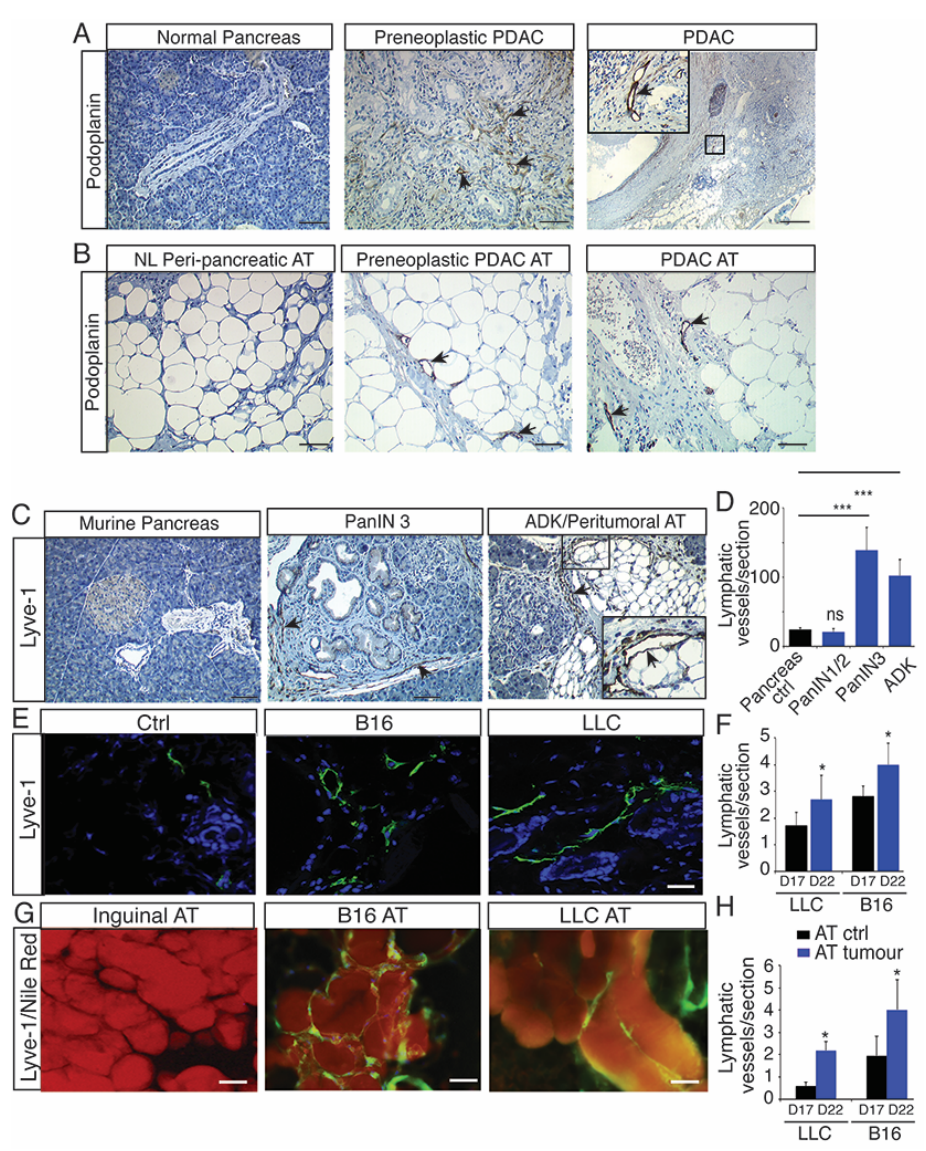
Figure 1. Lymphangiogenesis develops in primary tumors and its surrounding adipose tissue. ( A ) Representative images of podoplanin labelling in a normal human pancreas and in pancreatic ductal adenocarcinoma (PDAC) at preneoplastic and carcinoma stages (scale bar, 100 μ m) ( n = 15). ( B ) Representative images of podoplanin labelling in normal and peritumoral adipose tissue (AT) from human preneoplastic and PDAC (scale bar, 100 μ m) ( n = 15). ( C ) Representative images of Lyve-1 labelling in normal murine pancreas, PanIN3 and adenocarcinoma stages in Pdx1Cre; LSLKrasG12DInk4a +/ − (PKI) mice (scale bar, 50 μ m). ( D ) Quantification of the lymphatic vessel density in tumors from PKI mice at preneoplastic (PanIN) and carcinoma stages (mean + sem; n = ten animals; *** p < 0.005, ns: not significant). ( E ) Representative images of Lyve-1 labelling in melanoma B16 (B16) and Lewis Lung Carcinoma (LLC) tumor models (scale bar, 50 μ m). ( F ) Quantification of lymphatic vessel density in LLC and B16 tumor models (* p < 0.001, n = ten animals). ( G ) Representative images of Lyve-1 and Nile red labelling in LLC and melanoma B16 peritumoral adipose tissue (scale bar, 50 μ m). ( H ) Quantification of the lymphatic vessel density in LLC and B16 peritumoral adipose tissue (mean + sem; n = ten animals; * p < 0.005).